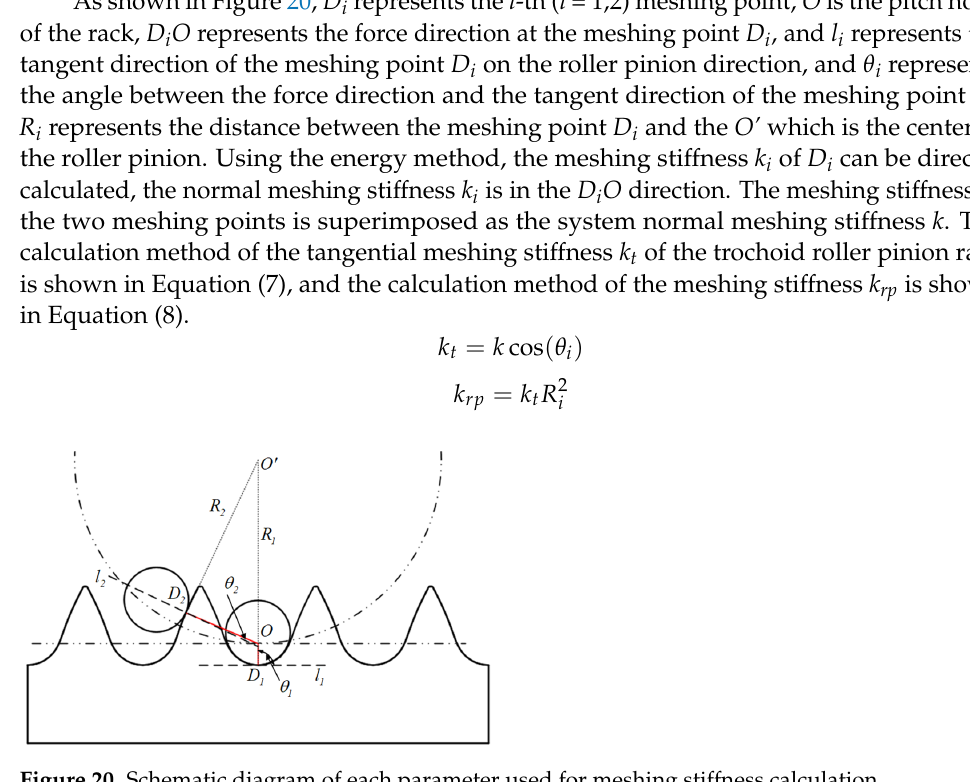
Figure 20. Schematic diagram of each parameter used for meshing stiffness calculation.